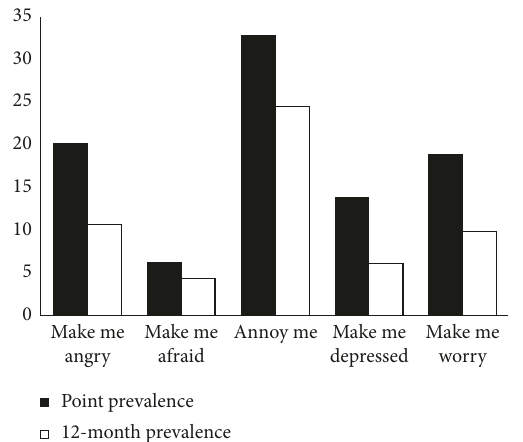
Figure 3: The impact of low back pain on medical students’